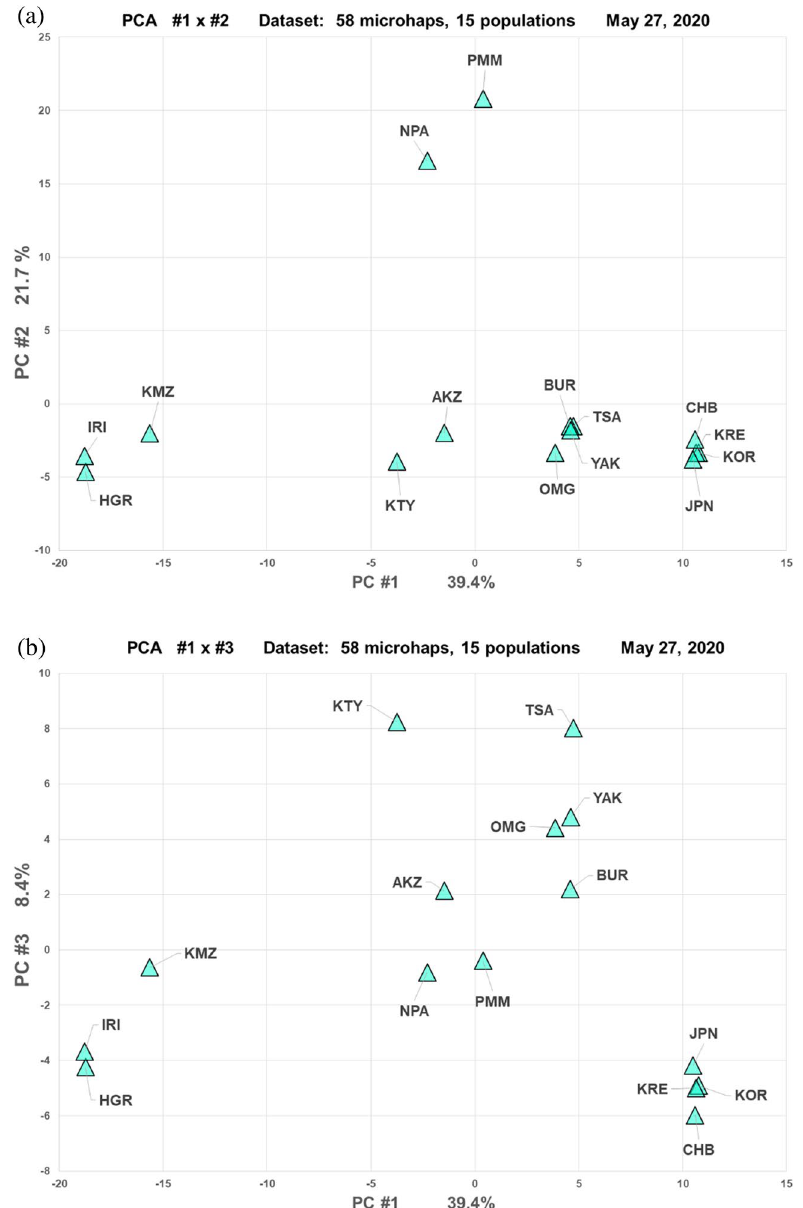
Figure 8. PCA results for 15 populations. ( a ) PC1 by PC2. ( b ) PC1 by